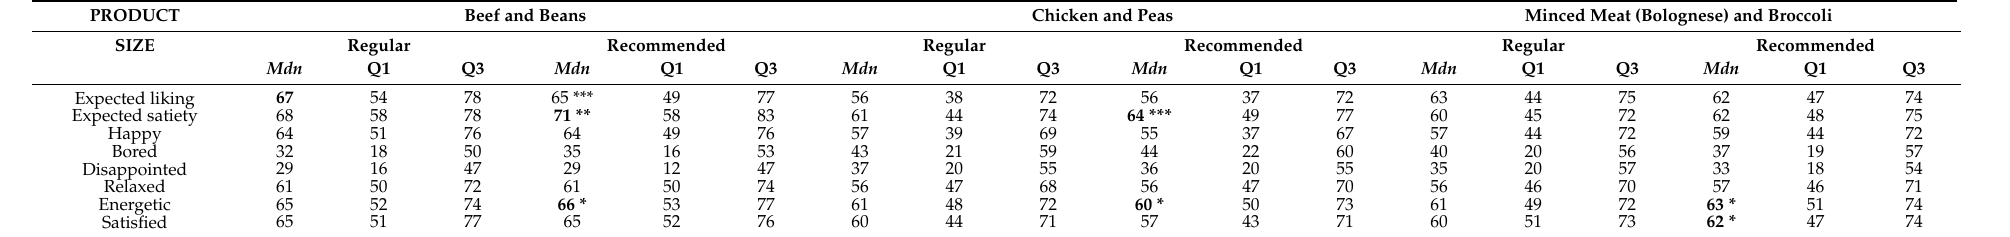
Table 2. Medians and interquartile ranges of the intensities of expected liking, expected satiety, and expected food-evoked emotions for regular and recommended portion sizes per meal.